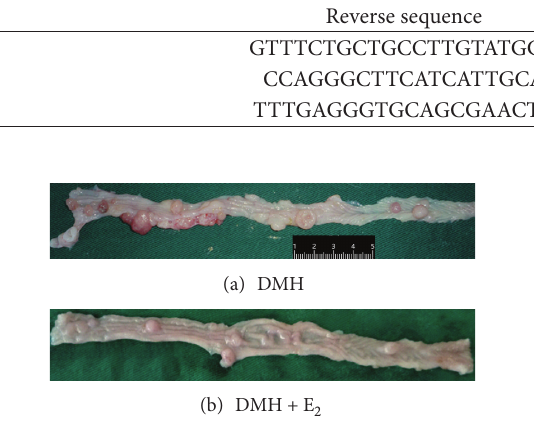
Figure 1: Polyps induced by DMH in experimental groups. (a) The polyps in DMH group. (b) The polyps in DMH + E 2